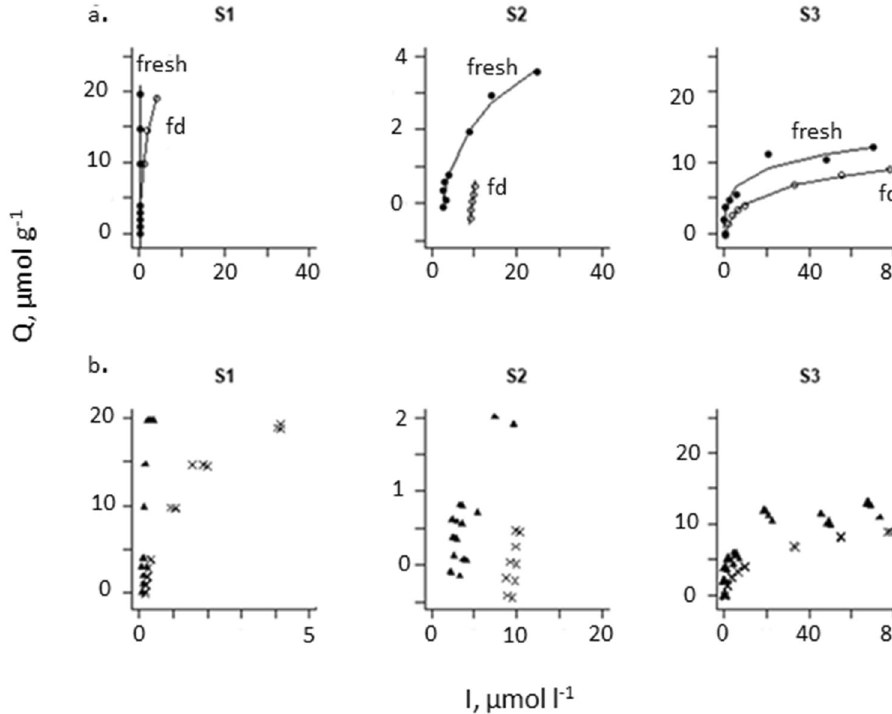
Fig. 2 Phosphorus exchange isotherms of fresh and freeze- dried (fd) sediments S1 − S3 drawn by using the average Q (amount of P desorbed from or sorbed onto the sediment) and I (equilibrium P concentration) values a , and Q and I values of the three replicates, separately b (triangles = replicate fresh samples, crosses = replicate fd samples). Solid-to-solution ratios were 1:200, 1:50 and 1:300 for sediments S1, S2 and S3, respectively. Note the different scales on the x- and